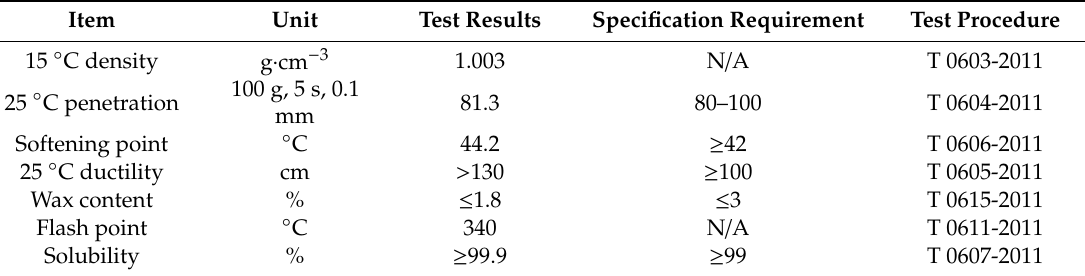
Table 1. Technical parameters of AH-90 base asphalt.